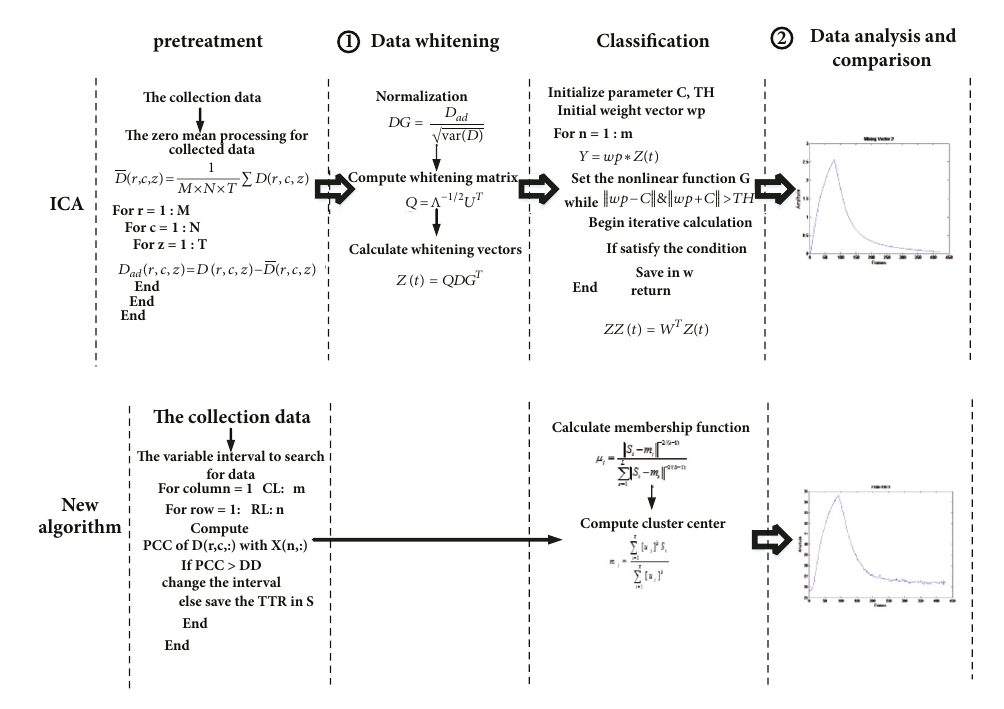
Figure 6: The comparison between the proposed method and